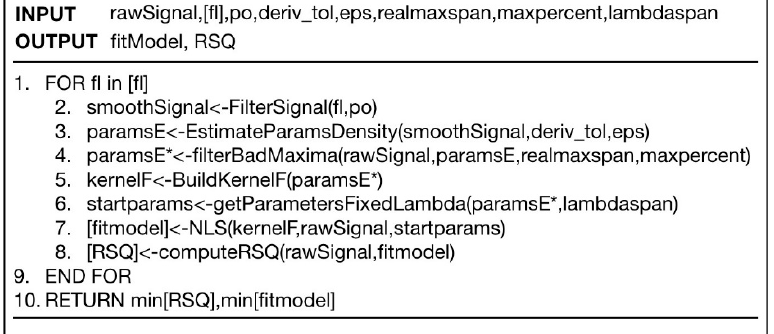
Figure 5. Pseudocode to implement decomposition of spectra into simple functions.